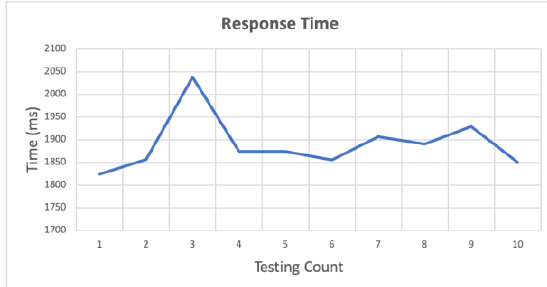
Figure 15. Response time of publish/subscribe between different devices after logical control of gateway. A Zero W as the SDC publishes a message, and then the other Zero W as the TDC subscribes a message.